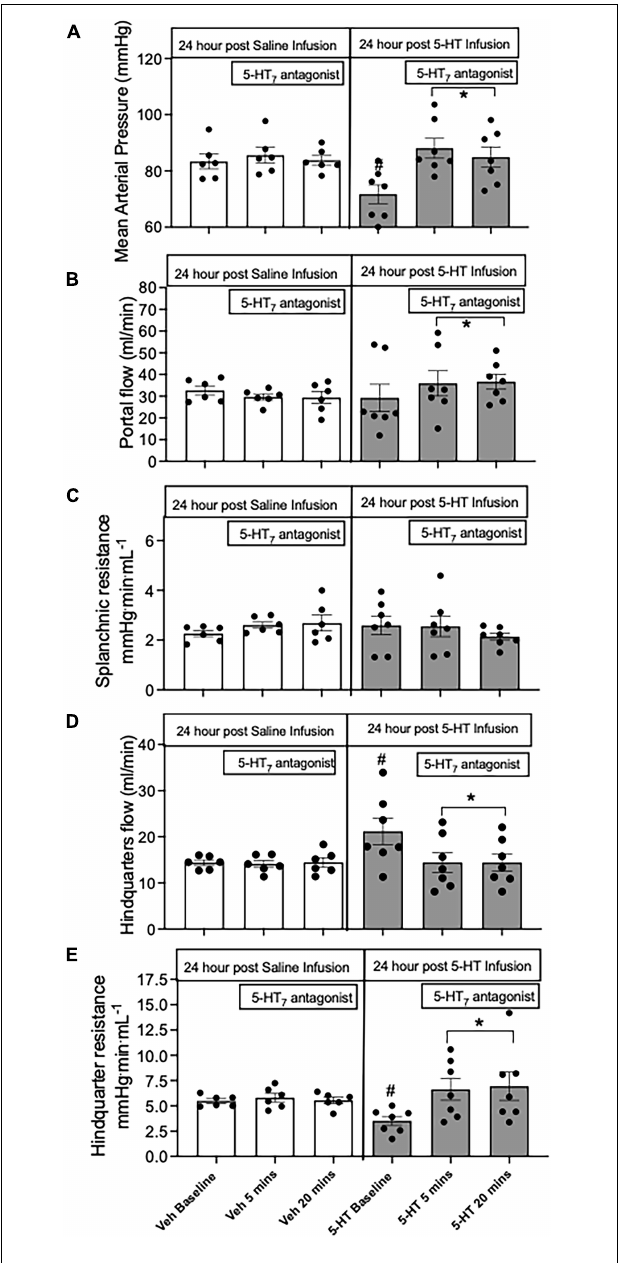
FIGURE 3 | Regional hemodynamic effects mediated by the 5-HT 7 receptor after 24 h of 5-HT infusion. The hemodynamic effects of (A) mean arterial pressure; (B) portal vein flow; (C) splanchnic resistance; (D) hindquarter flow; (E) hindquarter resistance after 24 h of infusion of either saline or 5-HT infusion (25 µ g/kg/min, osmotic pump) and challenged with the acute 5-HT 7 receptor antagonist SB269970 (33 µ g/kg, iv bolus). Columns represent distinct time points averaged ± SEM: n = 5–7 rats. Two-way ANOVA was used to determine significance within groups (*) and between group ( # ). In all cases p < 0.05 was